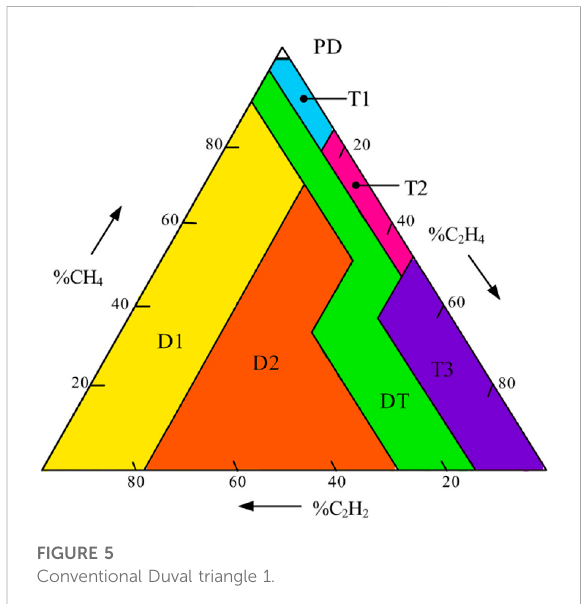
FIGURE 5 Conventional Duval triangle 1.